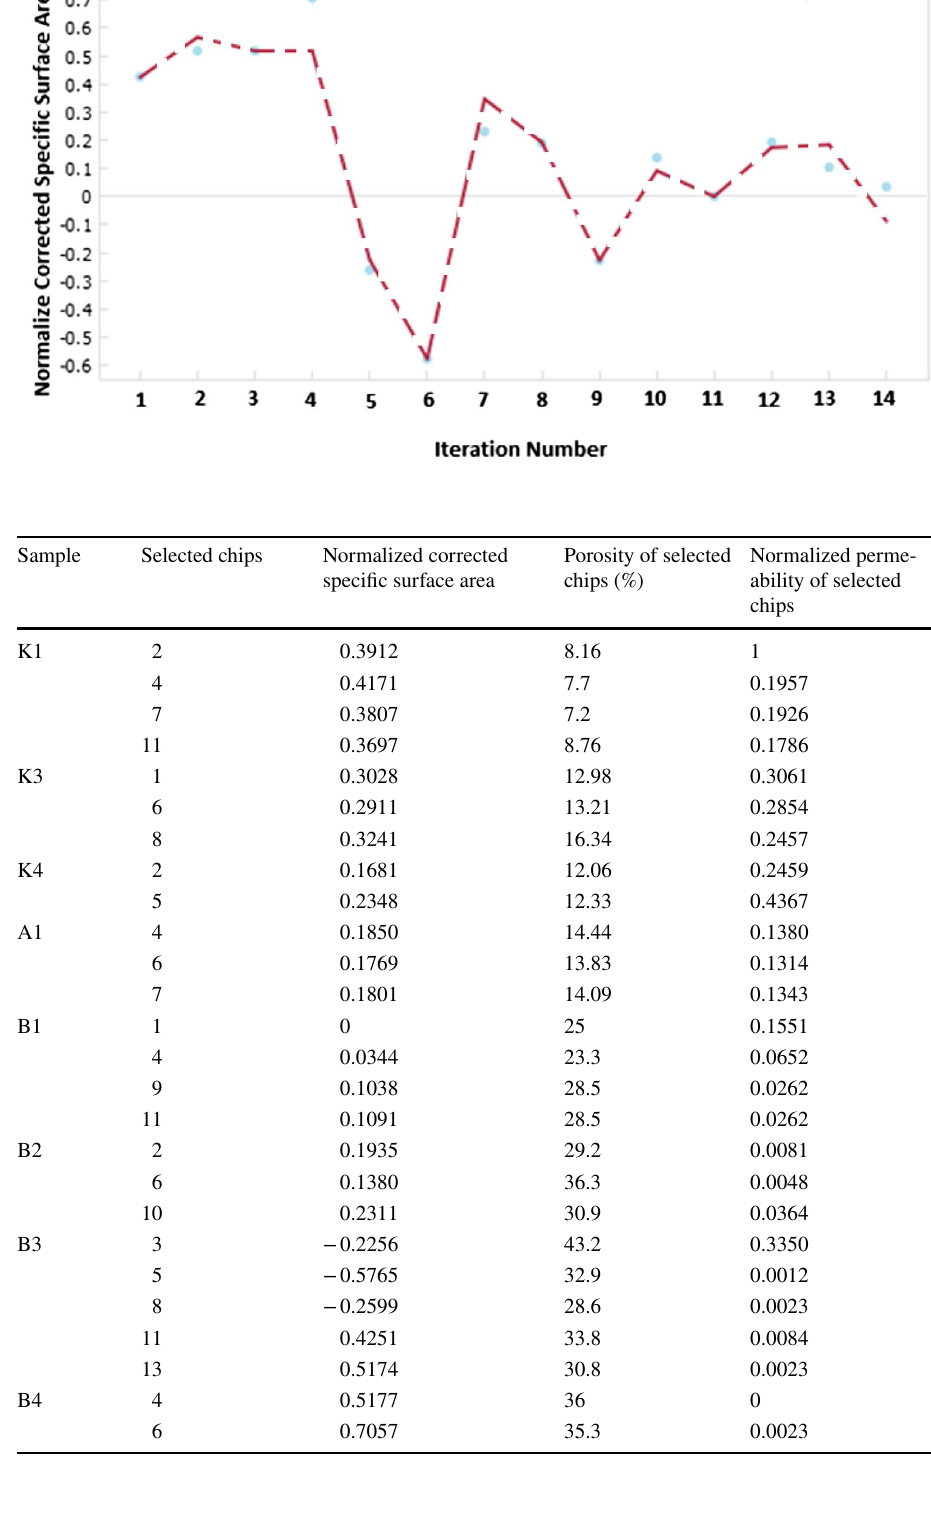
Fig. 11 Corrected specific surface area by calibration curve versus iteration number of estimation